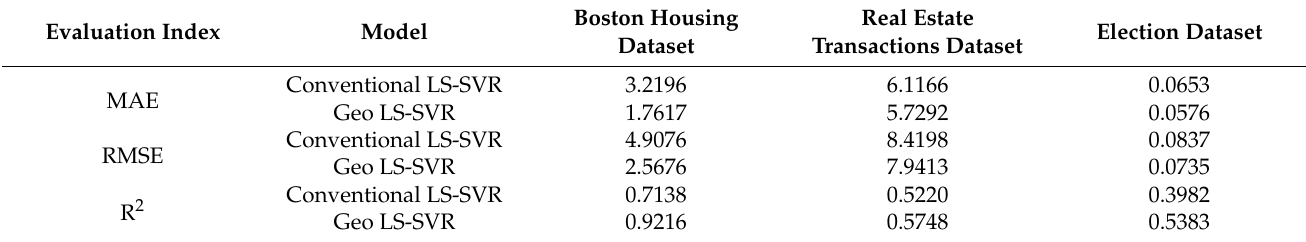
Table 2. Evaluation index value comparison between the conventional LS-SVR and 0–1 type Geo LS-SVR models.